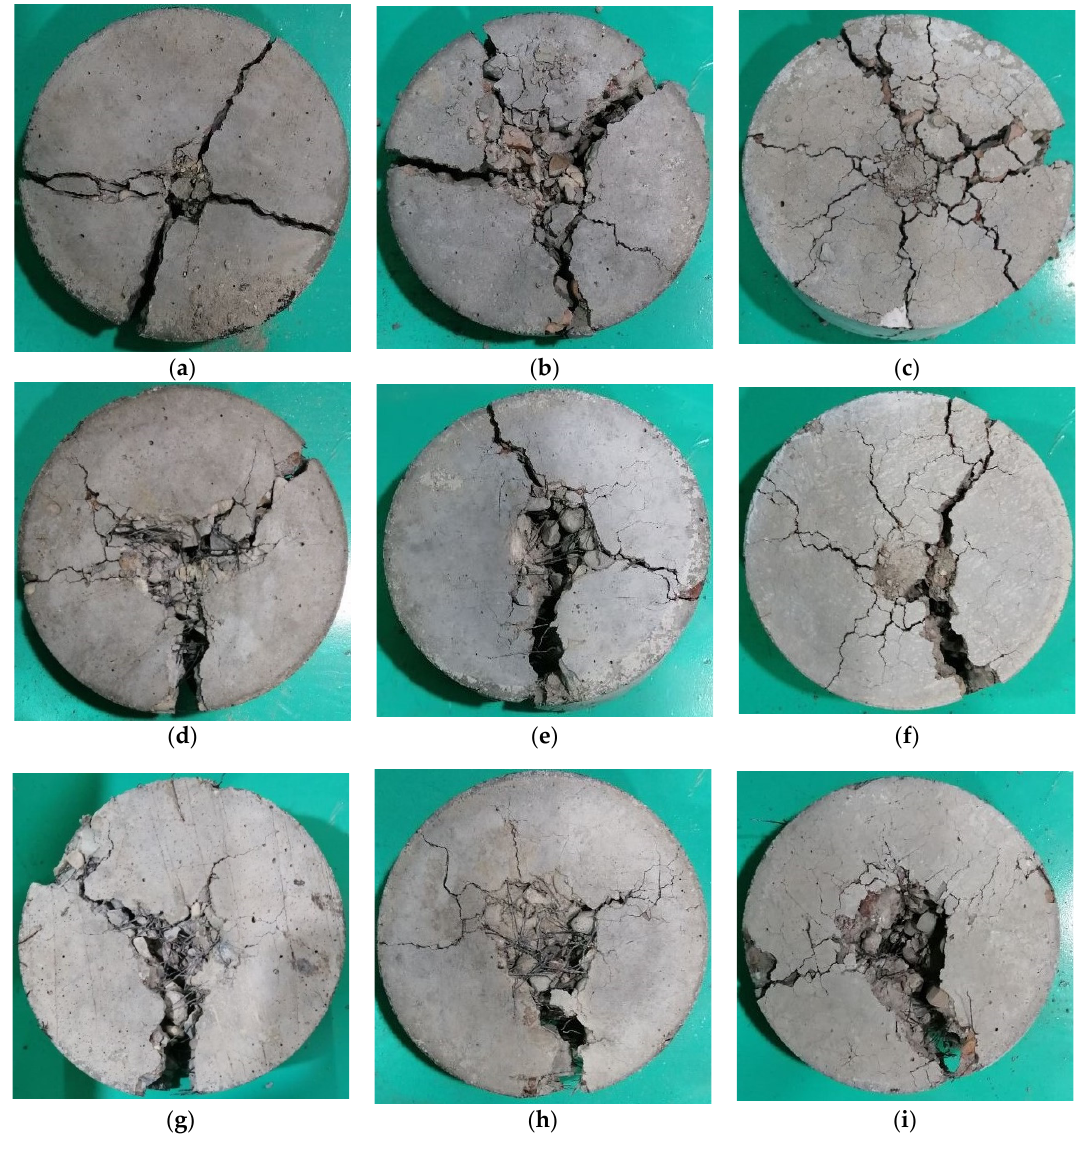
Figure 15. Failure patterns of heated specimens. ( a ) Vf = 0% 200 °C; ( b ) Vf = 0% 400 °C; ( c ) Vf = 0% 600 °C; ( d ) Vf = 0.5% 200 °C; ( e ) Vf = 0.5% 400 °C; ( f ) Vf = 0.5% 600 °C; ( g ) Vf = 1.0% 200 °C; ( h ) Vf